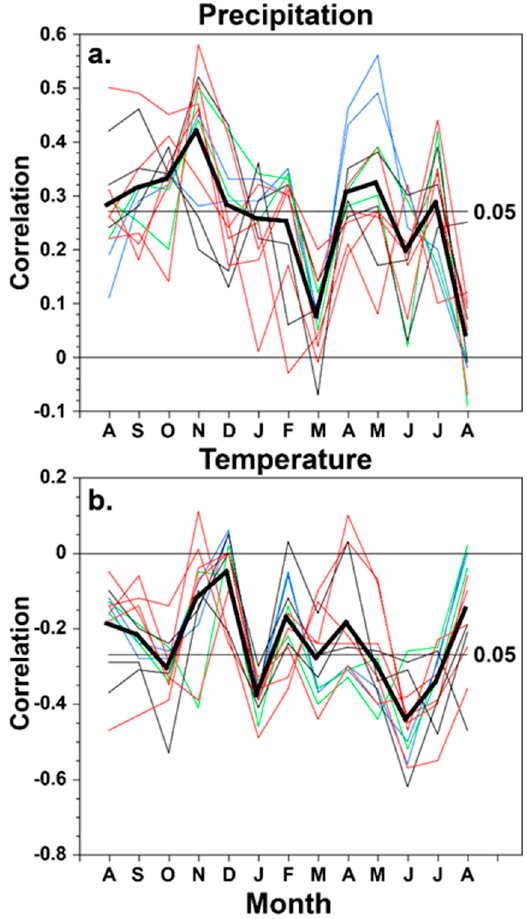
Figure 3. The monthly climate response for the 12 conifer tree-ring chronologies from the borderlands region is plotted, based on the correlation between each chronology and the monthly precipitation totals ( a ) and mean temperature ( b ) for the study area from the prior August to the current August. The response of the A. durangensis chronologies is plotted in blue, P. menziesii in green, P. arizonica in black, and P. cembroides in red. The average monthly correlation for the 12 chronologies is also plotted (heavy black line) and with the significance thresholds ( p < 0.05). The chronologies are listed in Table 1 and correlation coefficients are presented for all chronologies, climate variables, and months in Table 5. Correlation coefficients computed between each tree-ring chronology and monthly precip- itation and temperature data averaged for the study. All correlations were computed for the period 1946–2000 when the instrumental climate and the 12 tree-ring chronologies are most strongly repli- cated. Correlation values in bold are significant ( p < 0.05).